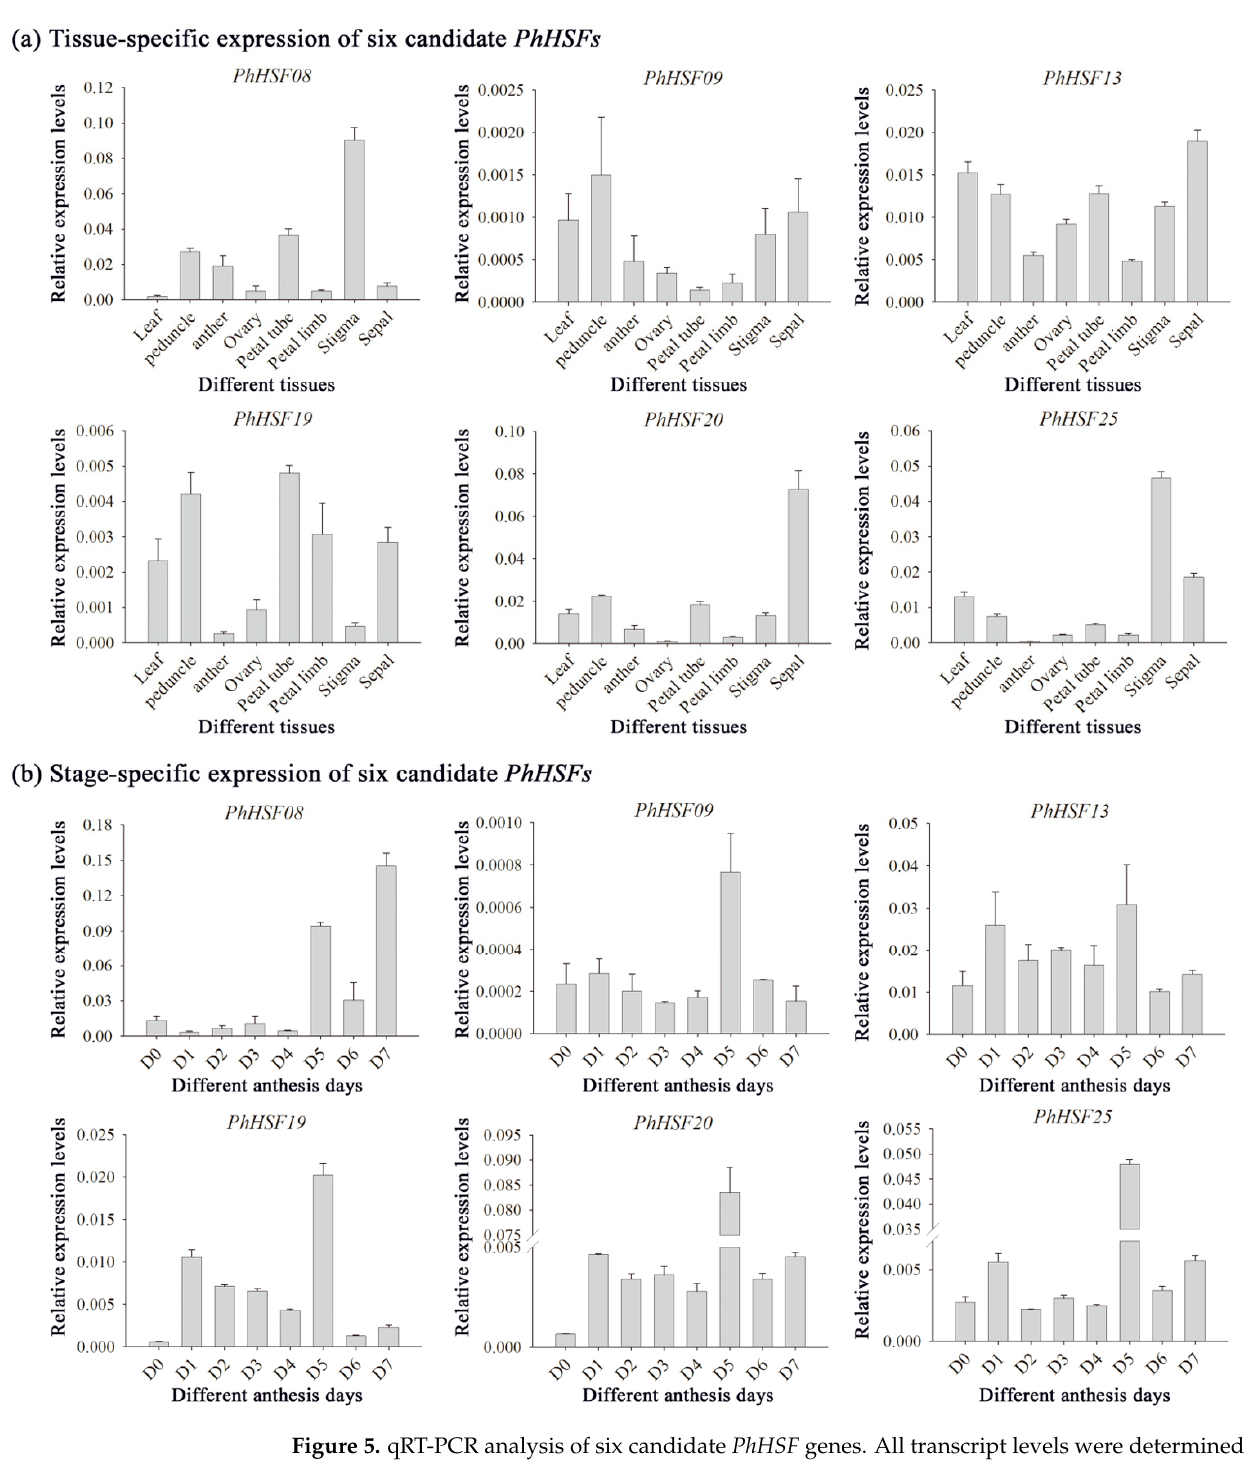
Figure 5. qRT-PCR analysis of six candidate PhHSF genes. All transcript levels were determined by qRT-PCR and were obtained relative to the reference gene ( PhEF1- α ). ( a ) Tissue-specific expression of PhHSFs in leaf, peduncle, anther, ovary, petal tube, petal limb, stigma, and sepal collected at 1500 h of day 1 post-anthesis (D1). ( b ) Stage-specific expression of PhHSFs from mature buds (D0) to day 7 post-anthesis (D7) at 1500 h. Representative histograms from multiple biological replications using the 2 −∆ CT method are shown (mean ± SE, n = 3).